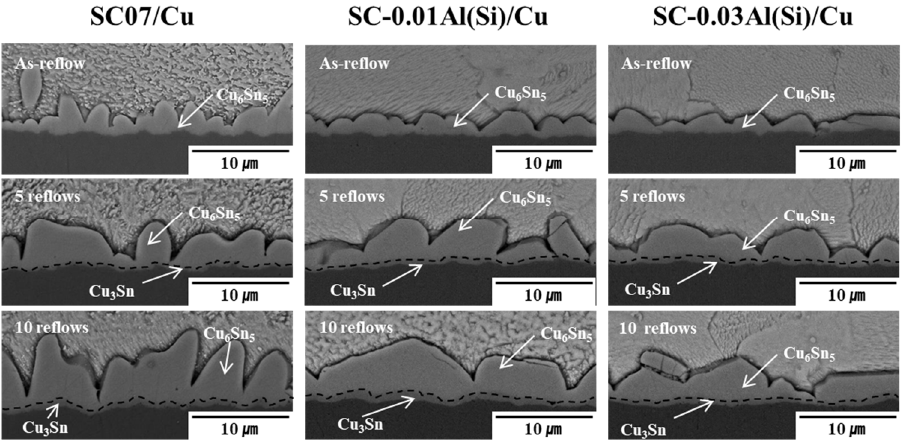
reflows. In the as-reflow specimen of the SC07 solder, the total IMCs grew significantly compared with the SC-0.01Al(Si) and SC-0.03Al(Si) solders, and no Cu 3 Sn was observed using SEM. Elongated, scallop-shaped Cu 6 Sn 5 IMCs were observed in the SC07 solder, and round, scallop-shaped Cu 6 Sn 5 IMCs were observed as the Al(Si) content increased. After 10 reflows, the total IMCs of the Sn-0.7Cu solder had grown the most significantly. This appears to have occurred because the Al compounds present near the grain boundary or interface inhibited the formation and growth of interfacial IMCs by blocking the diffusion of Sn and Cu atoms [31,32]. Cu 3 Sn IMCs were similarly observed in all three solders.